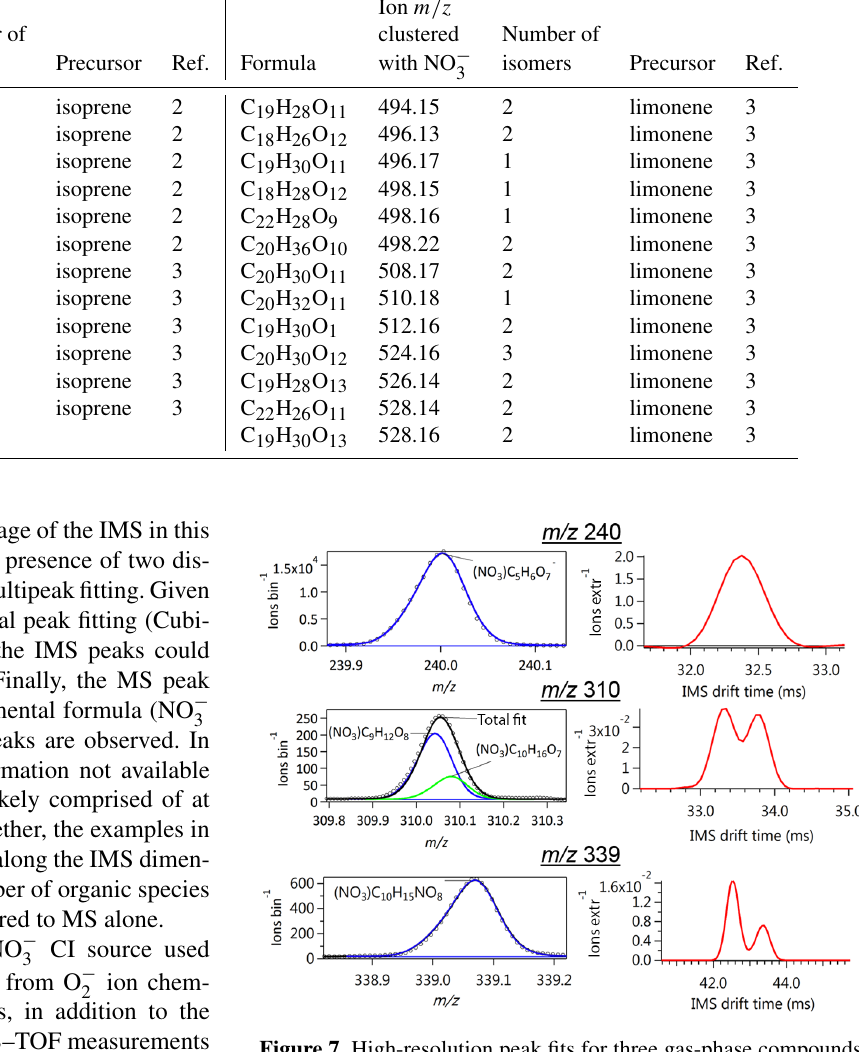
Figure 7. High-resolution peak fits for three gas-phase compounds along with the corresponding IM spectrum for each of the dis- played mass-to-charge regions. The compounds selected include a single isomer ( m/z 240), isobaric compounds ( m/z 310), and iso- meric compounds ( m/z 339). The elemental formulas at m/z 240 ) and m/z 310 (C 9 H 12 O 8 and (C 5 H 6 O 7 clustered with NO − 3 ) were previously identified as α - C 10 H 16 O 7 clustered with NO − 3 pinene ozonolysis products (Ehn et al., 2012). In this work they were extracted from spectra obtained during PAM flow reactor ex- periments of α -pinene oxidation with O 3 and OH. C 10 H 15 NO 8 ) was previously identified as a high- ( m/z 339 clustered with NO − 3 NO α -pinene oxidation product (Lee et al., 2016). The HR peak fits and IMS data shown for m/z 339 are extracted from ambient SOAS